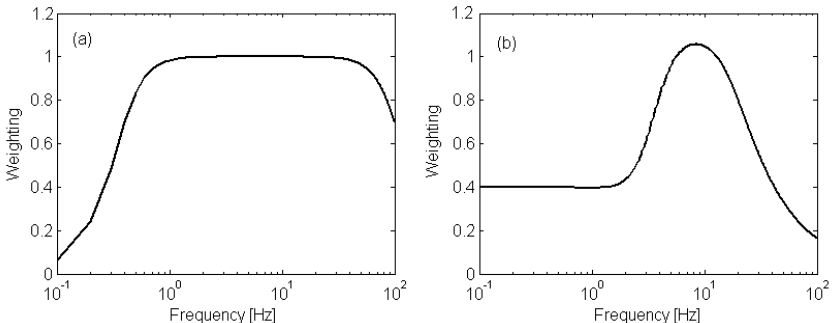
Figure 2. The frequency weighting functions: ( a ) of the filter W a ; ( b ) of the filter W b .